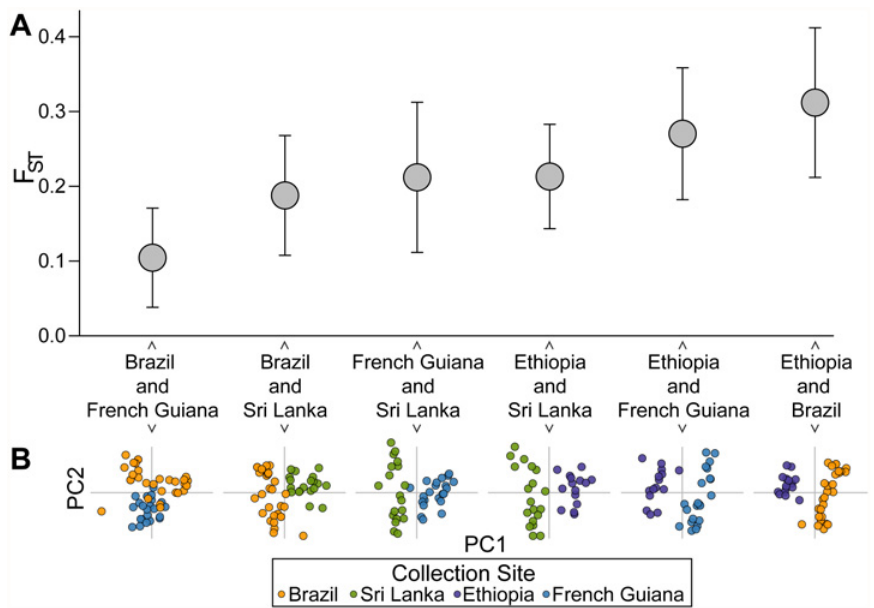
Fig 5. The 42-SNP barcode detects population divergence. (A) 95% confidence intervals for F ST values. All F ST values reflect statistically significant population divergence (p < 10 -5 ). (B) Population pairs separate in PCA with the first two principal